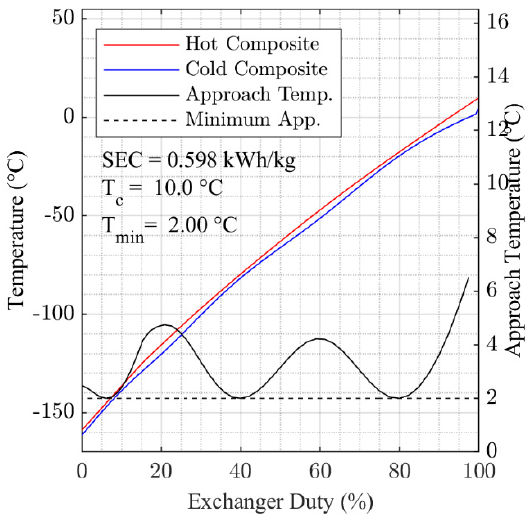
Figure A2. Optimized composite cooling curves for 10°C cooling temperature.